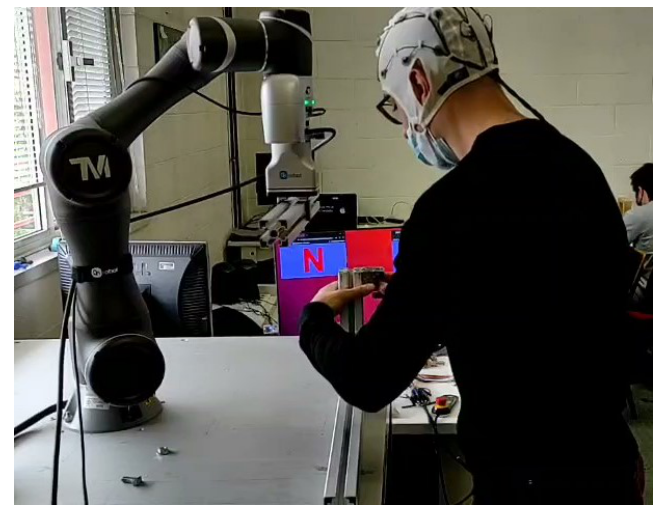
Figure 8. Independent phase. Step 3 of the assembly task.